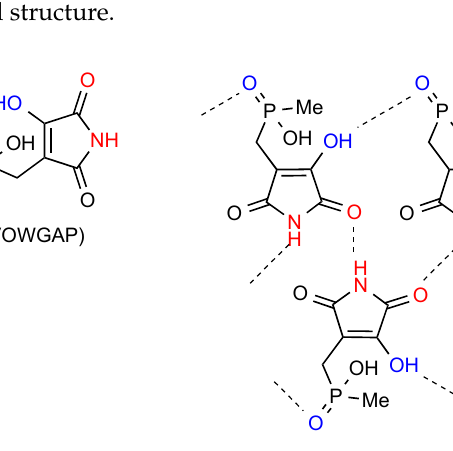
Figure 8. Structure observed for compound 25.